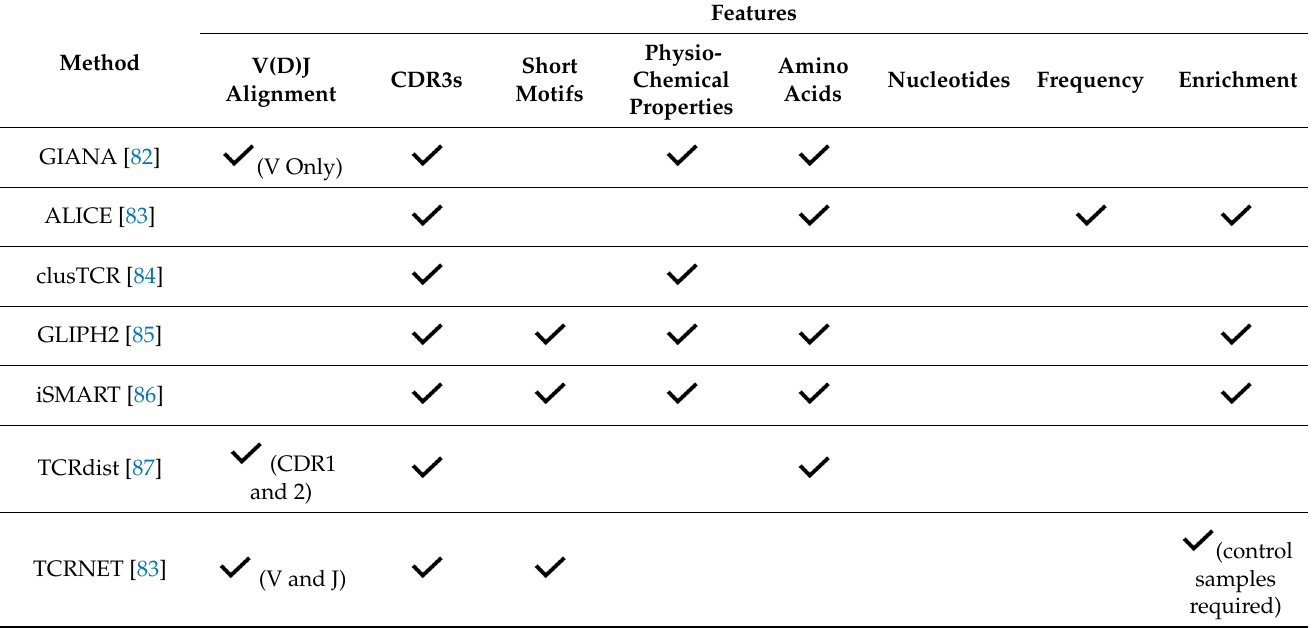
Table 3. TCR clustering methods.